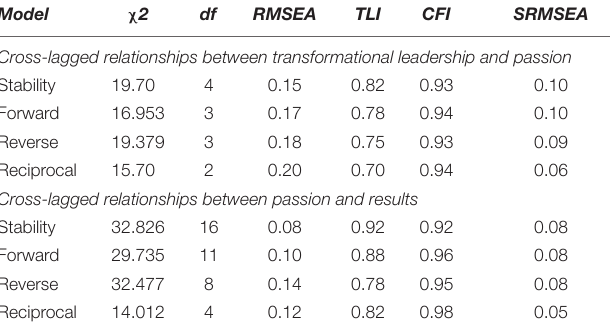
TABLE 3 | Fit indices for proposed models.